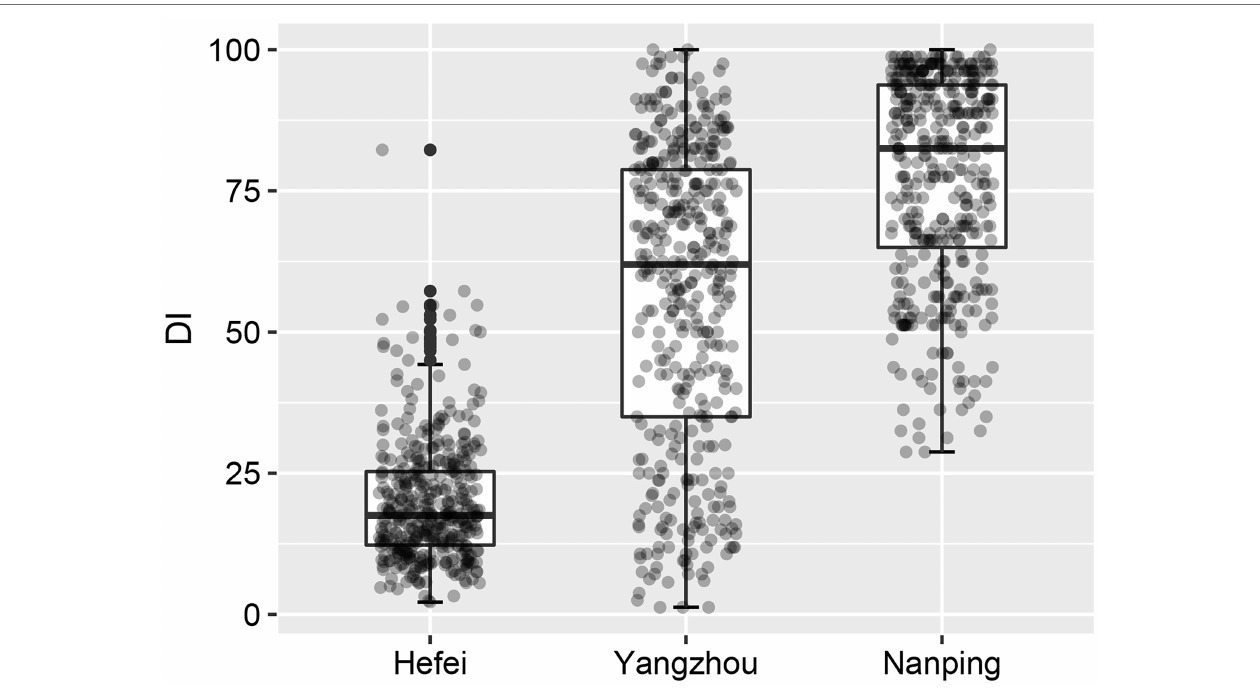
FIGURE 2 | Boxplots of the disease indexes of 410 wheat cultivars in three nurseries, demonstrating that the disease pressure in Hefei was much lower than in the other two